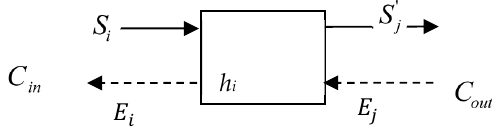
Figure 4. Outgoing Send stream is chaffed .